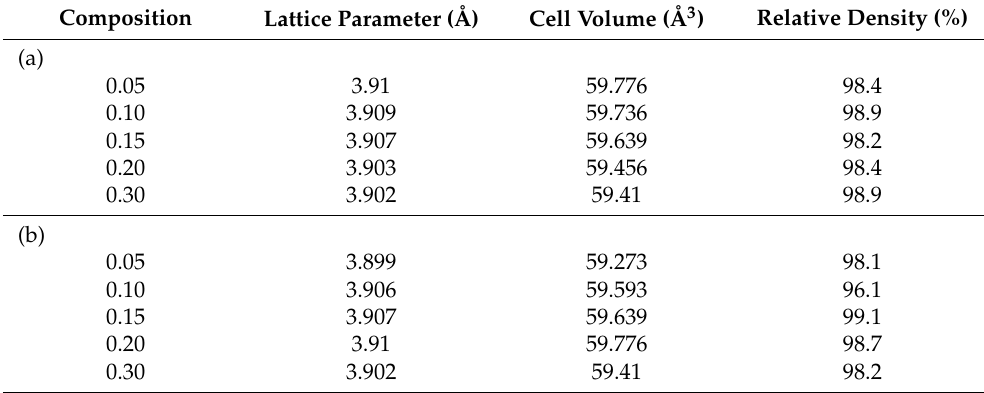
Table 2. Lattice parameters, cell volumes, and relative densities for (a) VSTO-A and (b) VSTO-H ceramics.